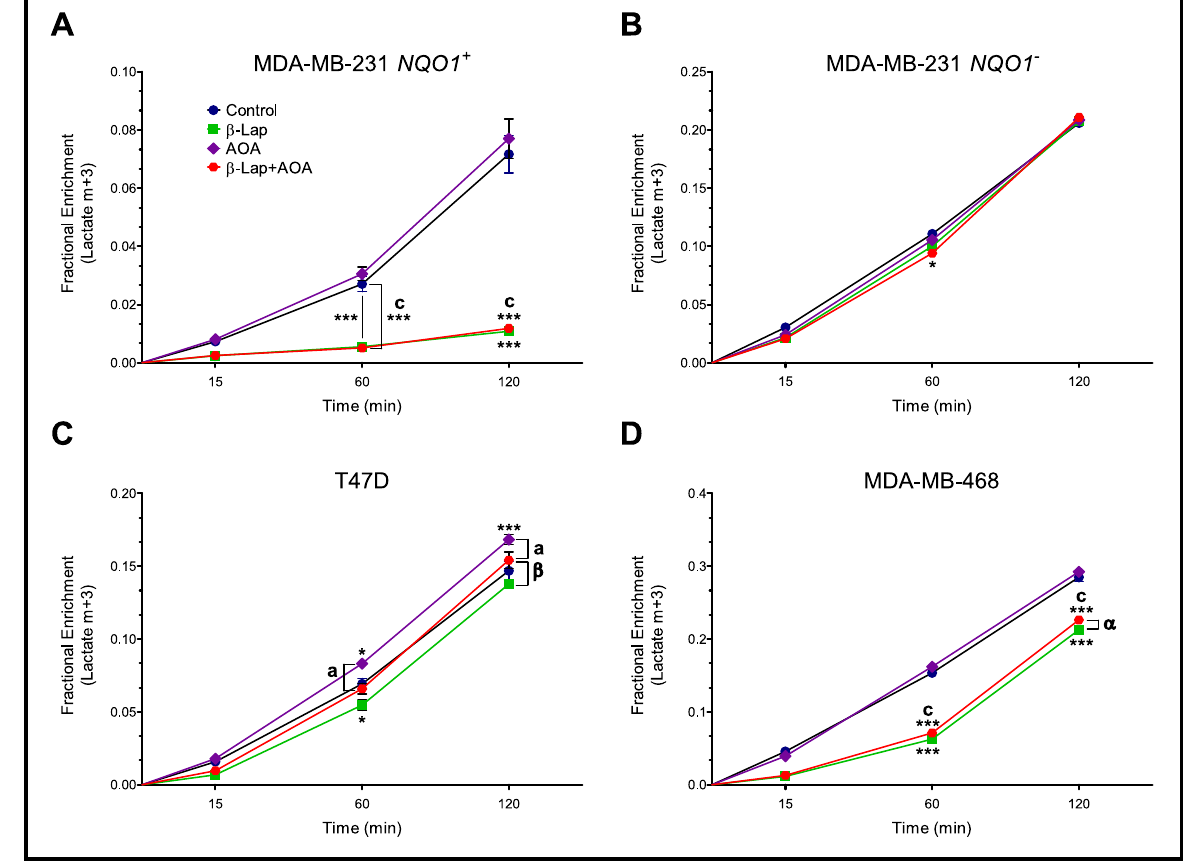
Figure 3. Kinetic analysis of extracellular lactate m+3 labeling over the course of 2 h after treatment. Panel ( A ) shows highly differential lactate production rates for MDA-MB-231 NQO1 + cells. In panel ( B ), MDA-MB-231 NQO1 − showed no drastic differences across treatment groups. T47D showed slight differences among treatment groups (Panel ( C )). MDA-MB-468 cells demonstrated lower production rates for β -lap and β -lap+AOA treatments (Panel ( D )). (Note: n = 3, biological